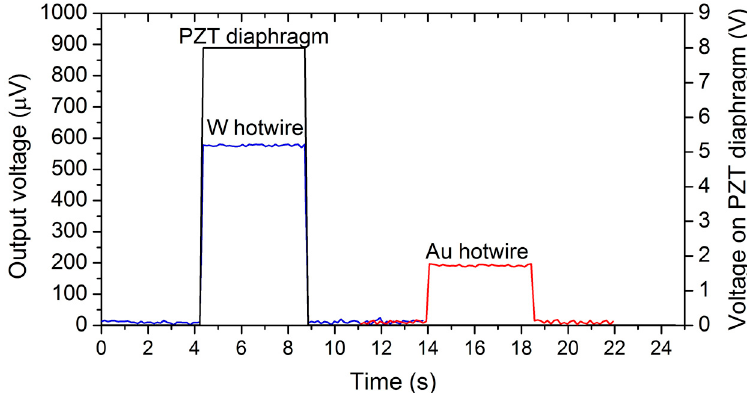
Figure 9. Hotwire voltage changes between gold hotwire and tungsten hotwire and the time-resolved data between actuating voltage and output voltage. The data corresponding to the gold hotwire was independently added to the same x -axis for clarification.